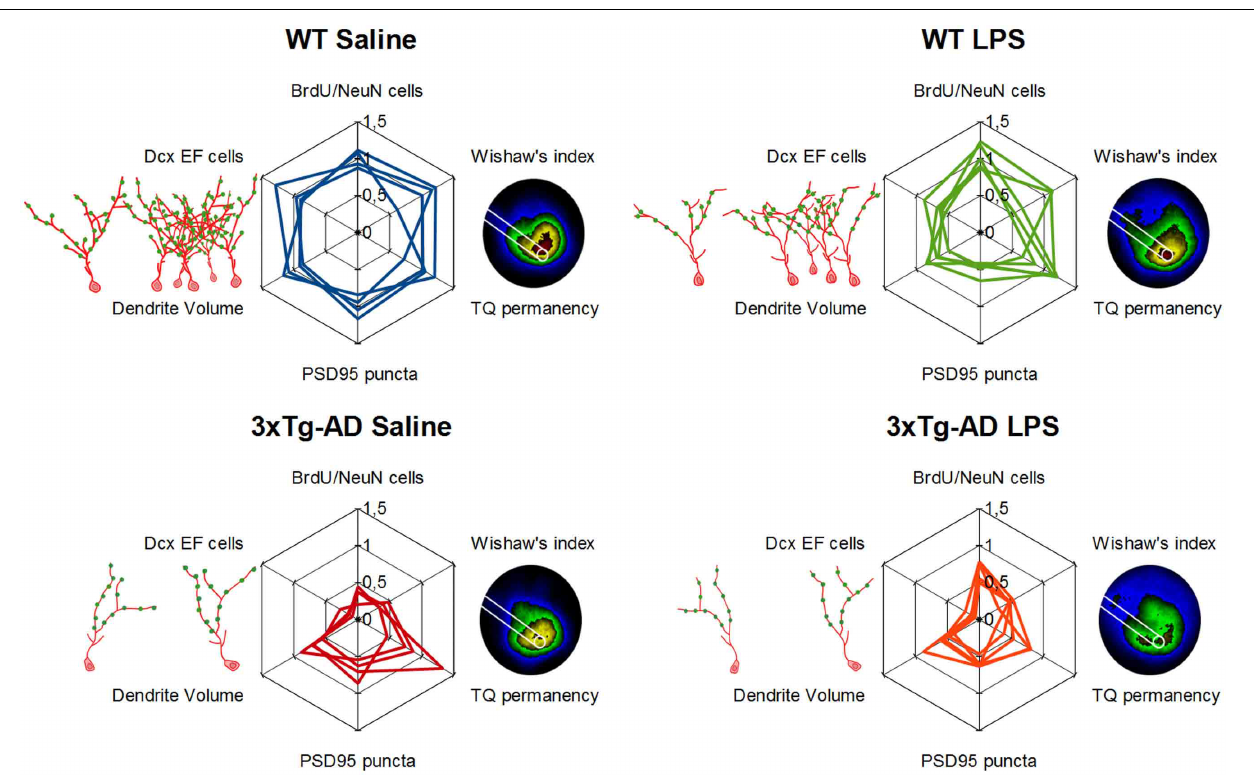
FIGURE 7 | Detrimental long-term effect of LPS induced inflammation in hippocampal neurogenic reserve and memory function. Schematic representation of main results. Doublecortin-positive EF cells, their morphology (red drawing) and synaptic puncta (green dots) are represented